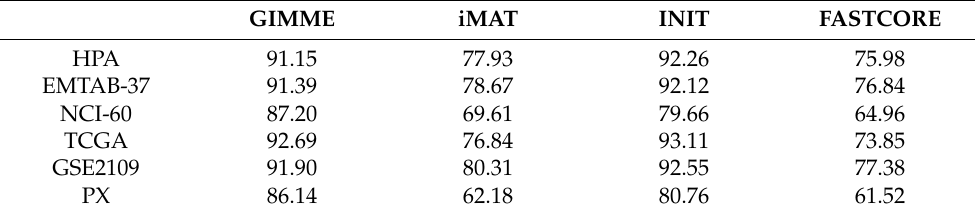
Table 4. The percentage of activated cancer genes in CGEMs of different datasets and methods.